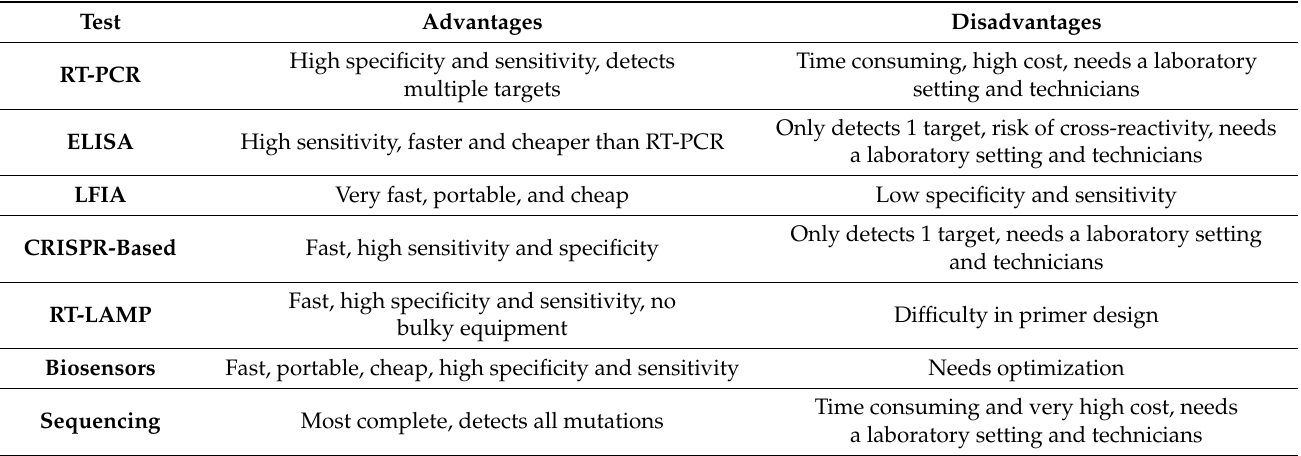
Table 4. Principal advantages and disadvantages of the different types of SARS-CoV-2 detection